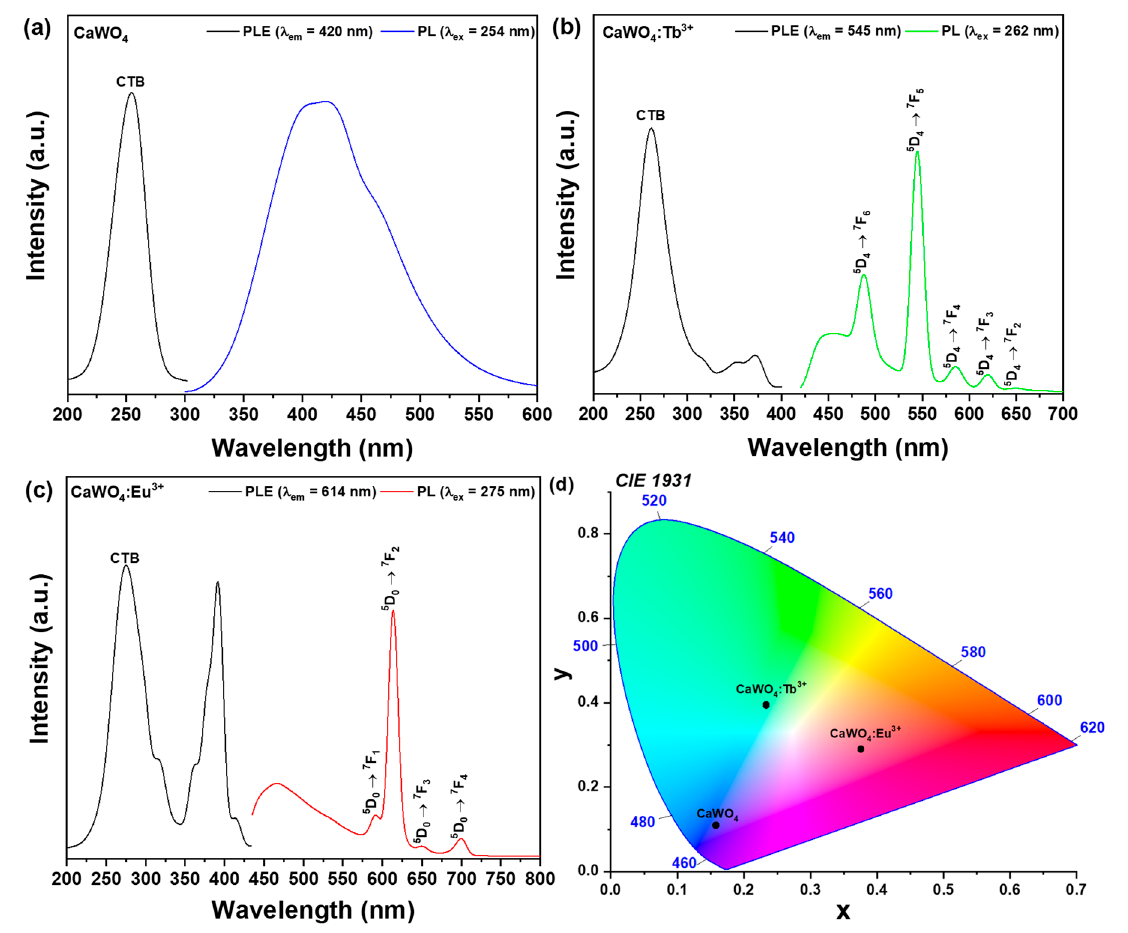
Figure 5. Luminescence spectra of ( a ) CaWO 4 , ( b ) CaWO 4 :Tb 3+ , and ( c ) CaWO 4 :Eu 3+ , and ( d ) CIE coordination.